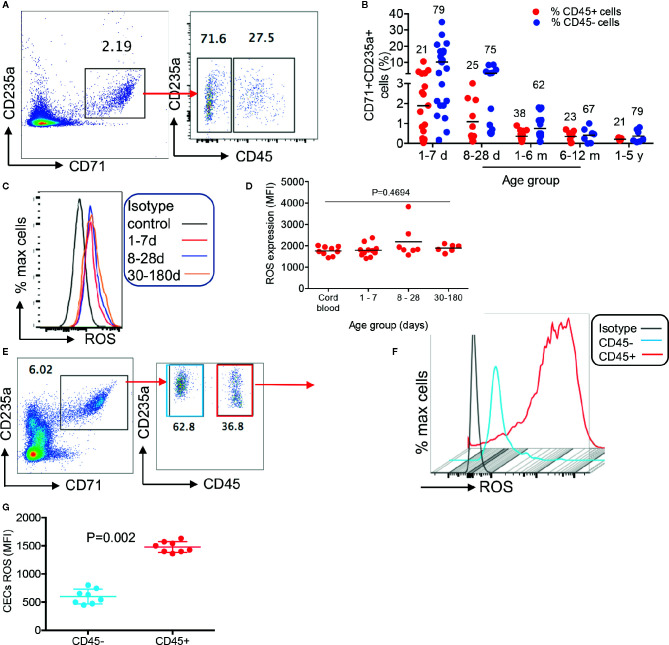
Differential expression of ROS by CD45+ versus CD45−CECs in humans. (A) Representative plot showing differential expression of CD45 in CECs from a human infant. (B) Cumulative data showing percentages of CD45+ and CD45− CECs in human infants/children from day-1 to 5 years of age. The numbers on red and blue symbols showing % CD45+ or CD45−CECs. (C) Representative histogram of ROS expression in CECs, and (D) cumulative data showing mean fluorescence intensity (MFI) of ROS in CECs from human cord blood and neonatal blood at shown ages. (E) Representative plots showing frequency of CD45+ versus CD45− CECs in the peripheral blood of an 8-day-old human newborn. (F) Representative histogram of ROS expression in CD45+ versus CD45−CECs in an 8-day-old human newborn. (G) Cumulative data showing mean fluorescence intensity (MFI) of ROS in CD45+/CD45−CECs of human newborns.